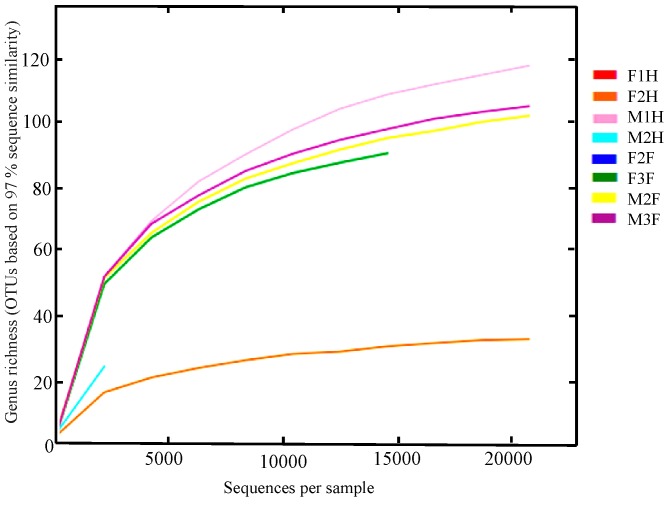
Alpha diversity showing the richness of bacterial community diversity within Dicathais orbita foot (F2F, F3F, M2F and M3F) and hypobranchial gland samples (F1H, F2H, M1H and M2H) (F = female; M = male).The phylogenetic diversity metric consists of genus richness based on 3585 observed OTUs at the 97% sequence similarity level and 443 possible observed genus. Sample with reads of more than 3000 are visible.